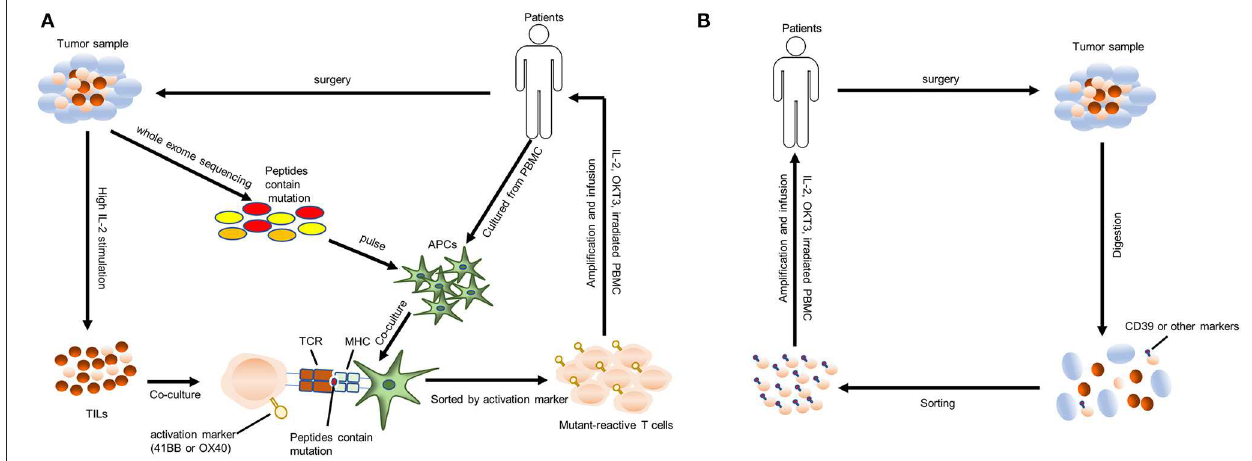
FIGURE 1 | Protocols for identifying and transferring tumor-reactive T cells. (A) A “blueprint” for the therapy of patients using autologous T cells that recognize tumor-specific mutations. TILs, tumor-infiltrating lymphocytes; APCs, antigen-presenting cells; MHC, major histocompatibility complex; TCR, T cell receptor; PBMC, peripheral blood mononuclear cell. (B) A “blueprint” for the therapy of patients with autologous T cells recognizing tumor cells that were sorted by chronic activation markers such as